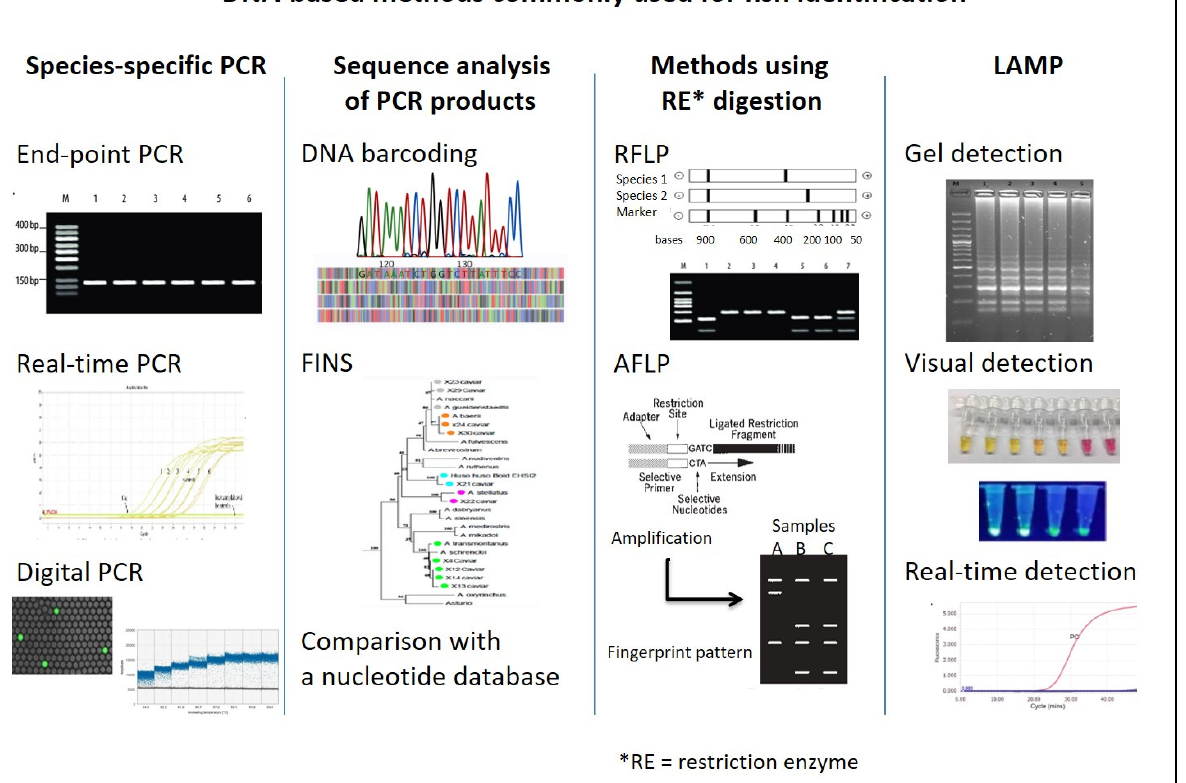
Figure 2. Schematic representation of commonly used DNA-based methods and data analysis ap- Schematic representation of commonly used DNA-based methods and data proaches for fish species identification. PCR = Polymerase Chain Reaction; FINS = Forensically In- formative Nucleotide Sequencing; RFLP = Restriction Fragment Length Polymorphism; AFLP = Am- analysis approaches for fish species identification. PCR = Polymerase Chain Reaction; plified Fragment Length Polymorphism; LAMP = Loop-Mediated Isothermal Amplification. FINS = Forensically Informative Nucleotide Sequencing; RFLP = Restriction Fragment Length